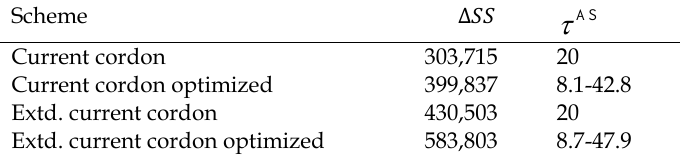
Table 2. Results (in SEK) for the Stockholm network, from Ekström et al. (2014).